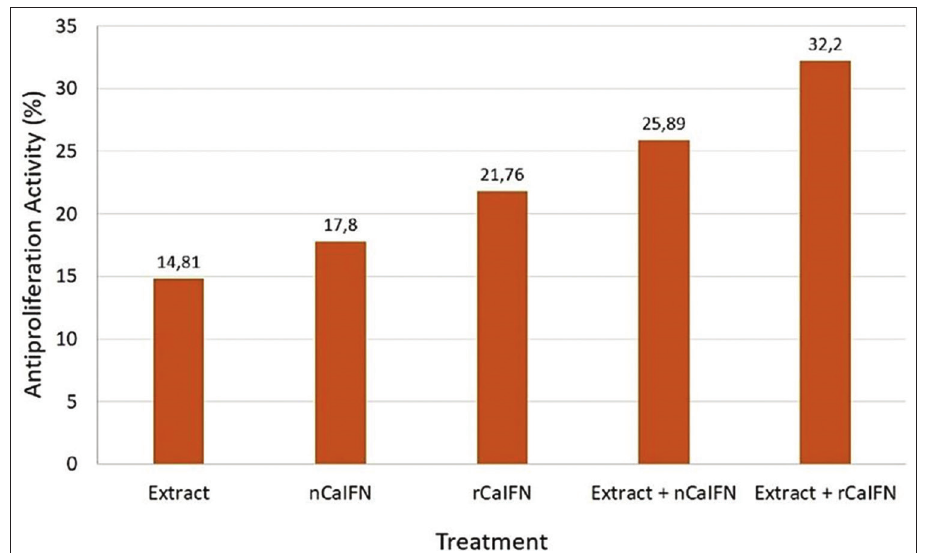
Figure-3: In vitro antiproliferation activity of Typhonium flagelliforme leaves ethanol extract, natural canine interferon and recombinant canine interferon single or in combinations on the rabbit endothelial cell lines.